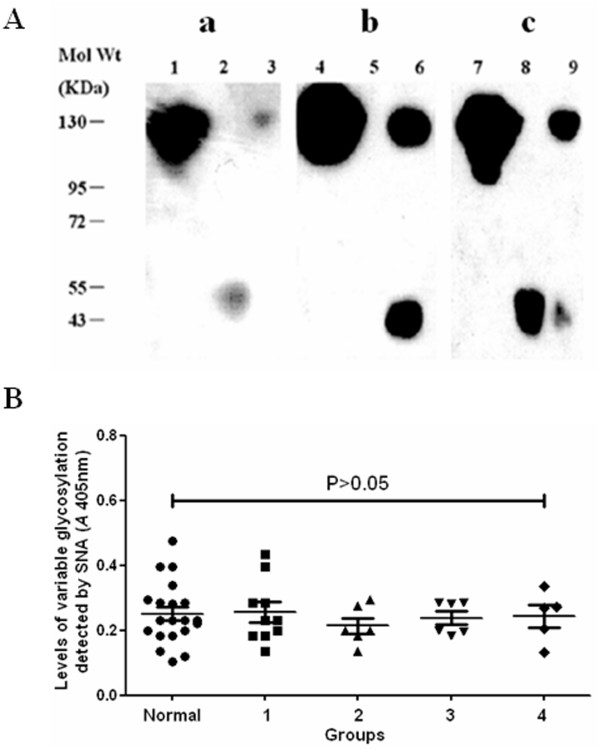
Identification of the binding specificity of SNA. A: Western-blot analysis of intact IgG, IgG-Fab and IgG-Fc after papain digestion. a: Detection with mouse polyclonal anti-Fab antibodies. Lane 1: intact IgG; lane 2: flow-through fraction of protein A-Sepharose; lane 3: eluted fraction of protein A-Sepharose. b: Detection with mouse polyclonal anti-Fc antibodies. Lane 4: intact IgG; lane 5: flow-through fraction of protein A-Sepharose; lane 6: eluted fraction of protein A-Sepharose. c: Detection with SNA. Lane 7: intact IgG; lane 8: flow-through fraction of protein A-Sepharose; lane 9: eluted fraction of protein A-Sepharose. B: Comparison of variable region glycosylation levels of plasma total IgG between patients and normal controls. Normal: 20 normal controls; group 1: 10 patients with anti-MPO antibodies; group 2: 6 patients with both anti-GBM antibodies and anti-MPO antibodies; group 3: 6 patients with anti-GBM antibodies without anti-MPO antibodies; group 4: 5 patients with anti-PR3 antibodies.